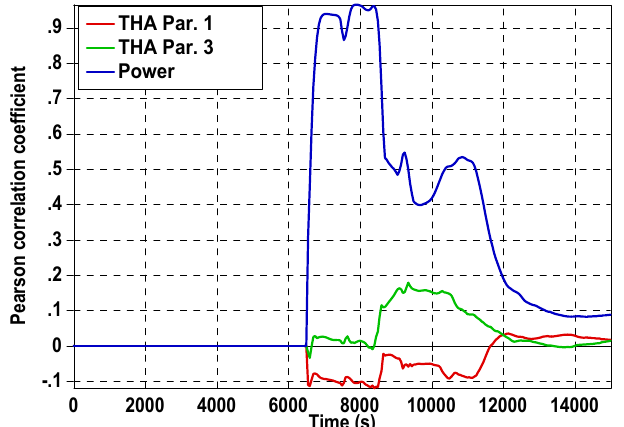
Figure 12. Pearson correlation coefficient between parameters related to core damage propagation and hydrogen production.